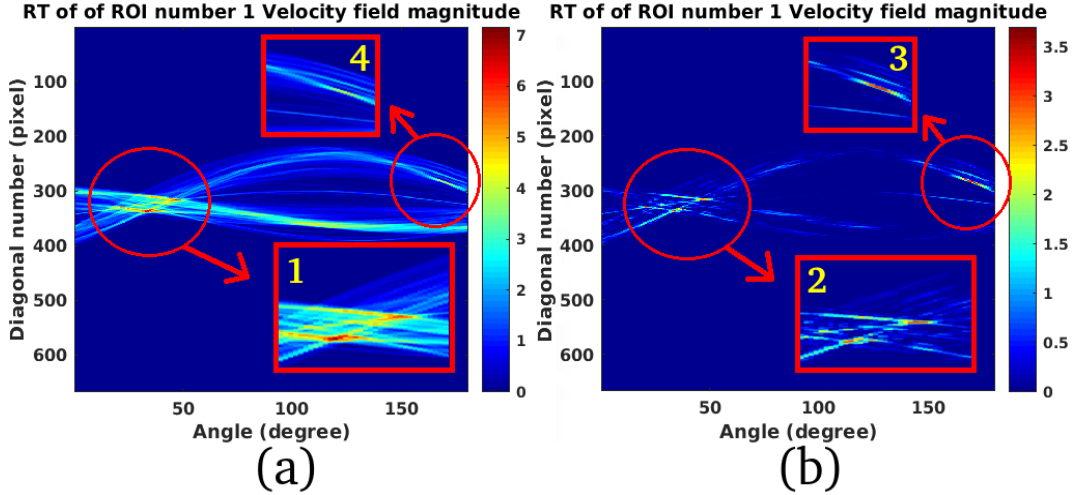
Figure 9. ( a ): RT of the displacement ROI. ( b ): Sparse component of the RT of the displacement ROI.